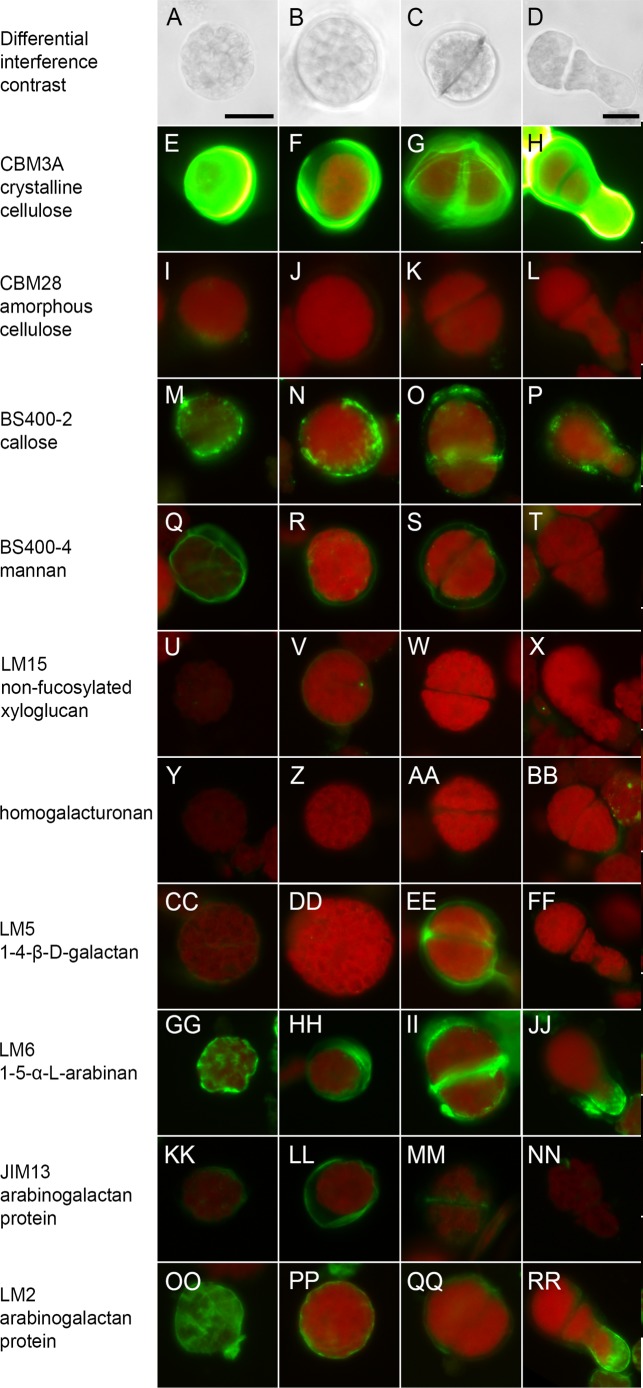
Protoplasts of Physcomitrella patens cultured for 24 h on protoplast regeneration medium and labeled with carbohydrate binding modules (CBMs) or antibodies. Differential interference contrast images show four stages of regeneration including (A) thin-walled stage, (B) thick-walled stage, (C) divided, and (D) filament extension and head columns of images of cells at the same stage and labeled with different probes. Protoplasts were labeled with (E–H) CBM3a for crystalline cellulose, (I–L) CBM28 for non-crystalline cellulose, (M–P) anti-callose (BS-400-2), (Q–T) anti-mannan (BS-400-4), (U–X) anti-xyloglucan (LM15), (Y–BB) anti-HG (LM19 in Y-AA, LM20 in BB), (CC–FF) anti-1,4-β-D-galactan (LM5), (GG–JJ) anti-1,5-α-L-arabinan (LM6), (KK–NN) anti-arabinogalactan protein (JIM13), and (OO–RR) anti-arabinogalactan protein (LM2) Bars = 20 μm.